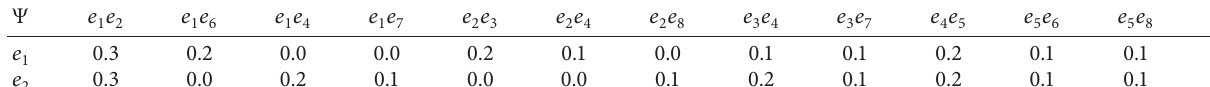
Table 7: Tabular representation of a fuzzy soft edge set.